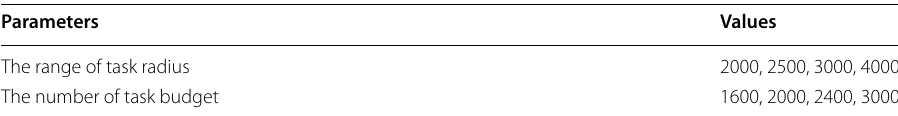
Table 8 Experimental